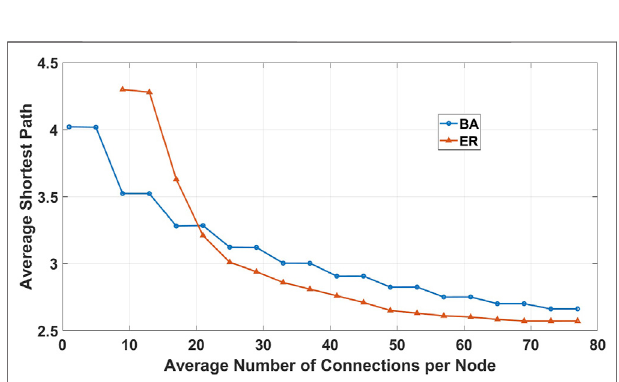
FIGURE 11 | Average shortest path for ER and BA networks for N = 10 000